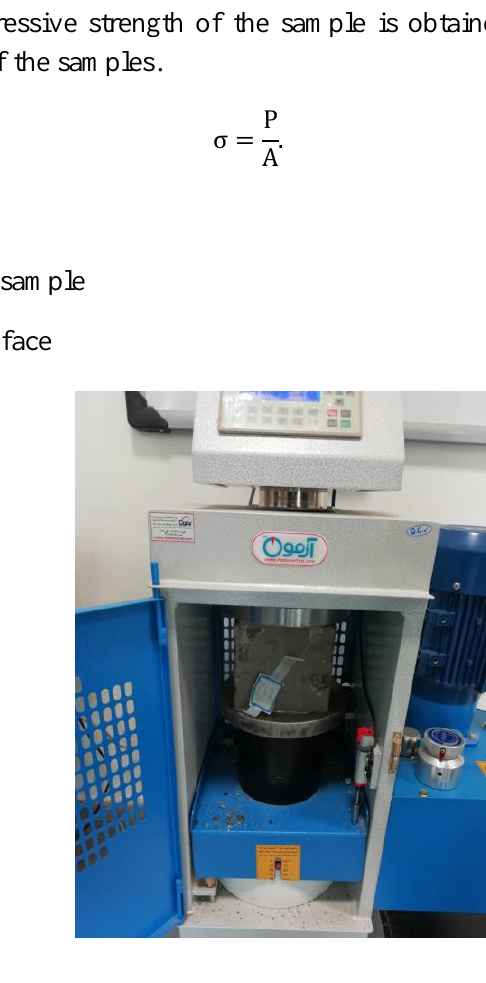
Figure 7. Performing compressive strength test of concrete . Table 13. Average compressive strength of